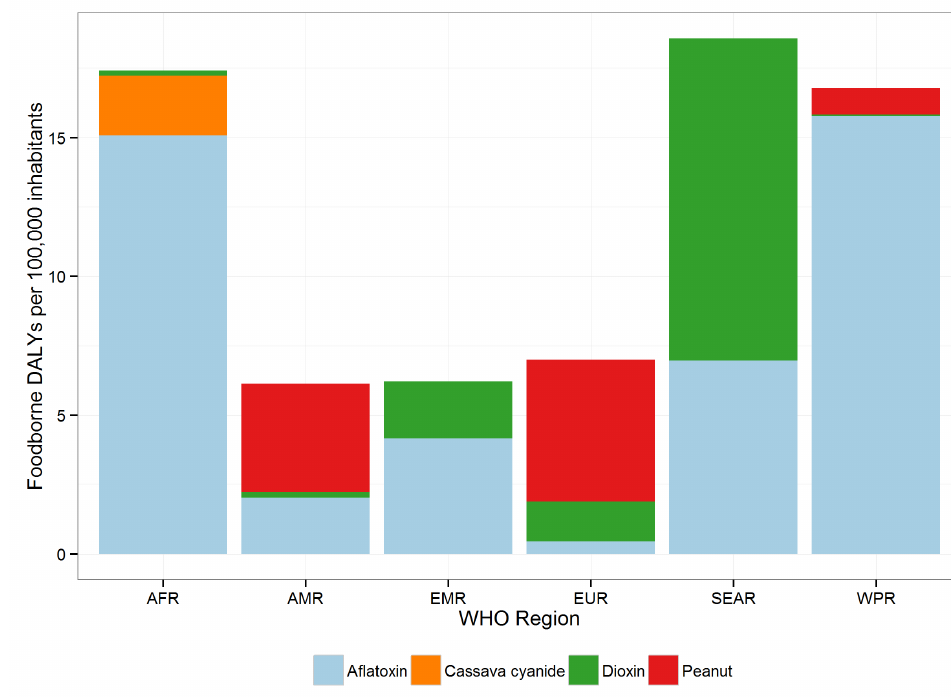
Figure 1. The relative contribution to the DALY incidence by each of four chemicals for each of the WHO regions.